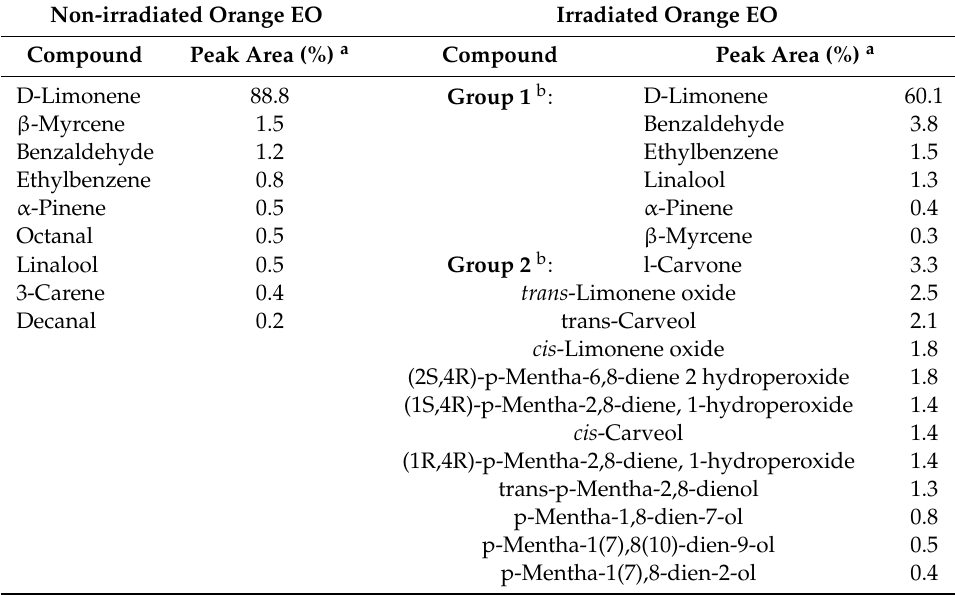
Table 1. Composition of non-irradiated and irradiated orange essential oil